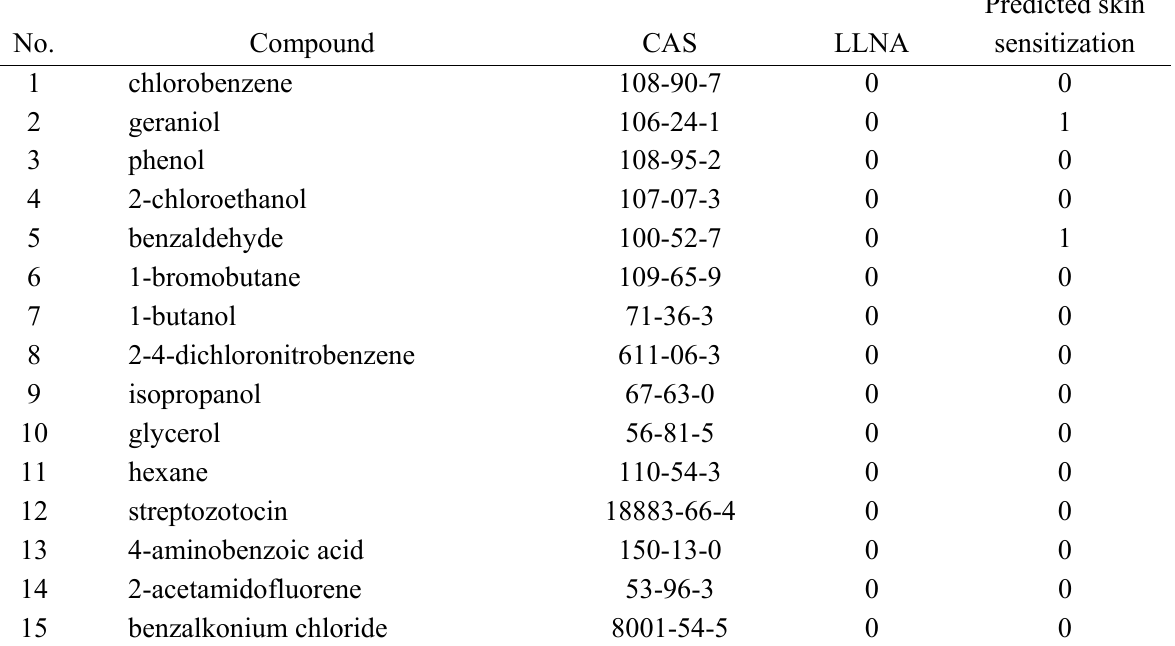
Table 4. LLNA-tested